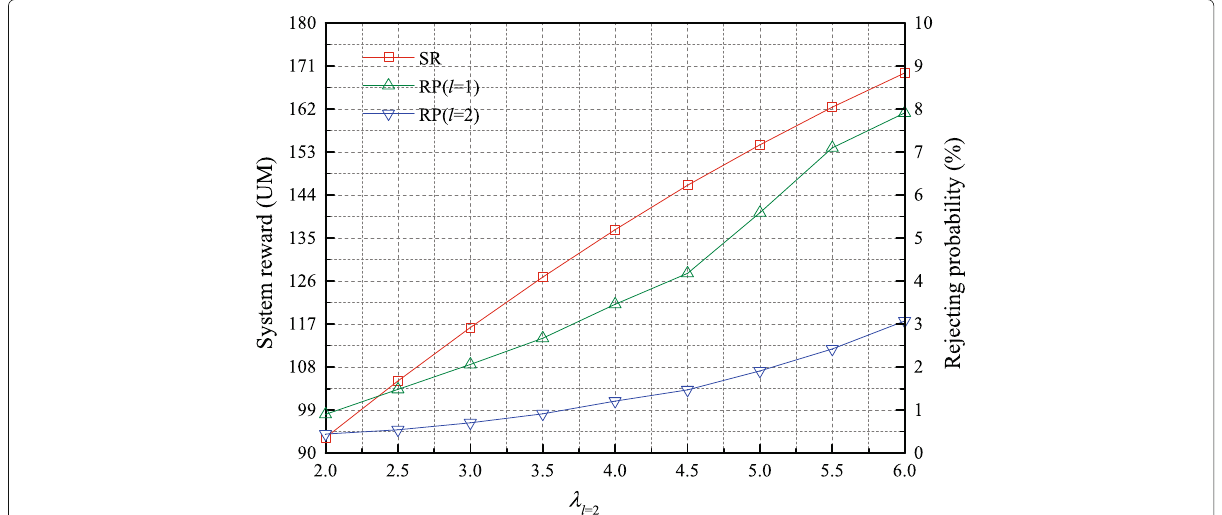
Fig. 8 SR and RPs under different arrival rates of the 2-level task request. This figure shows the evaluation results under different arrival rates of the 2-level task request. Figures 7 and 8 show the evaluation results under different arrival rates of the l -level task request